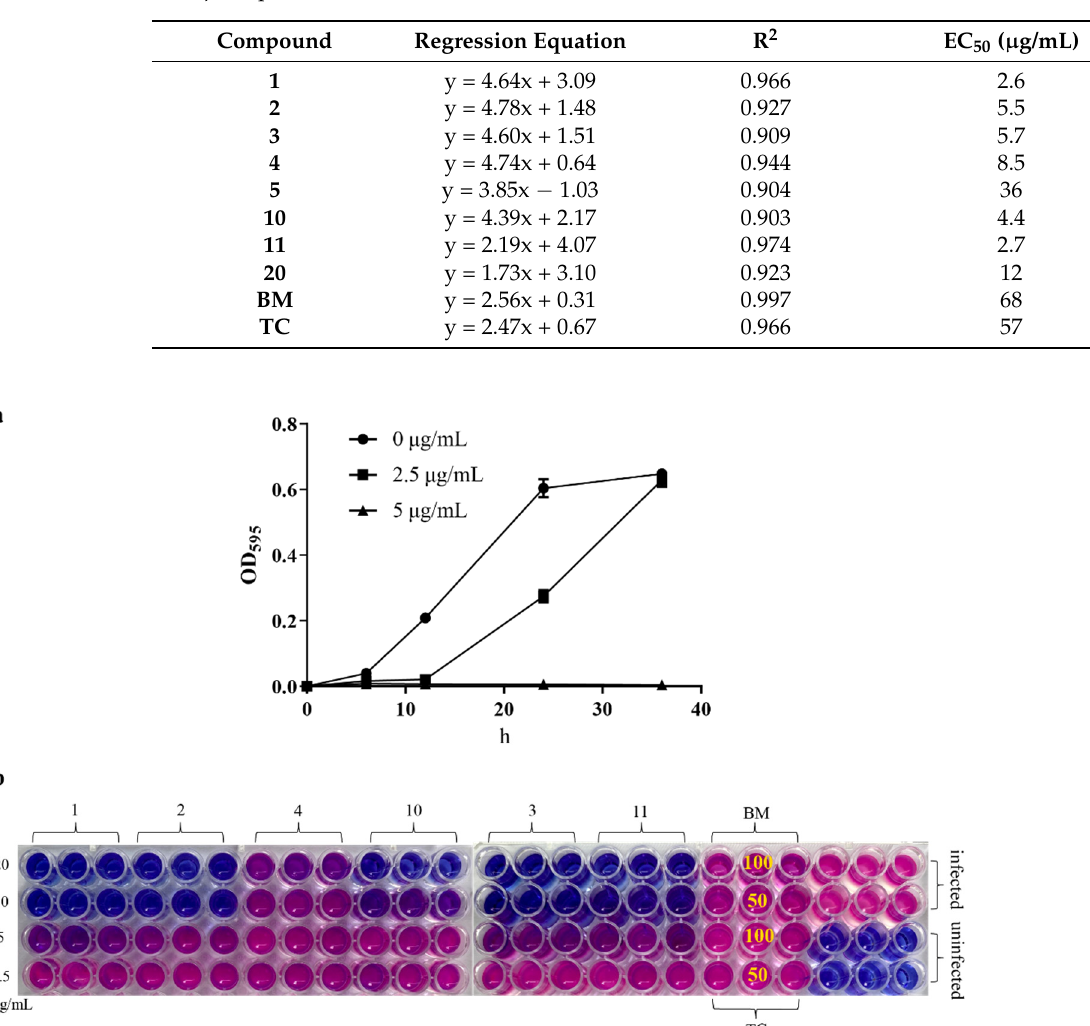
Table 2 . The half inhibitory concentration (EC 50 ) of the target compounds against Xanthomonas axonopodis pv. citri .